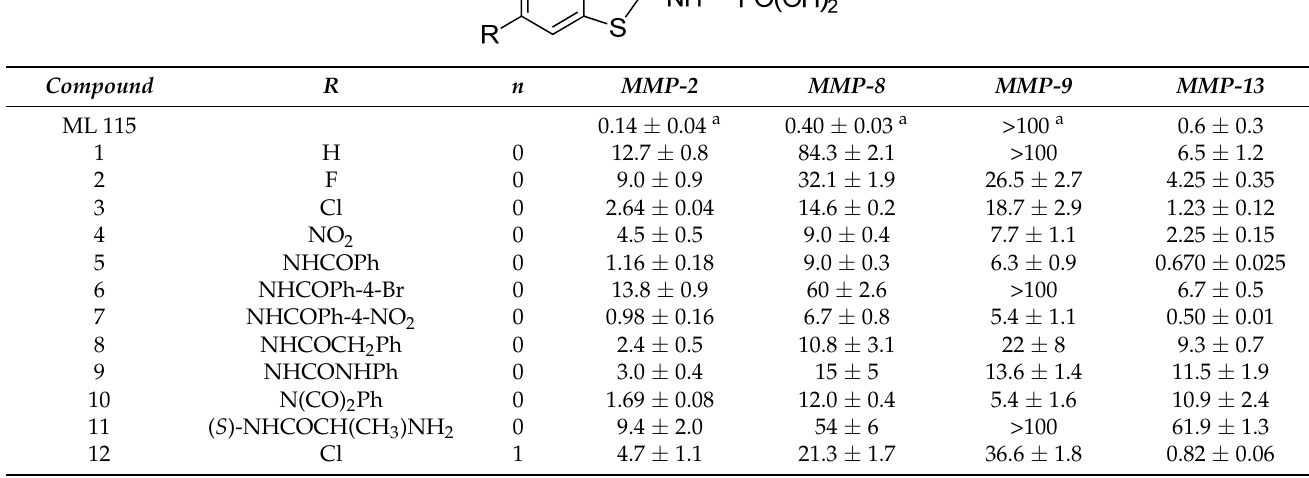
Table 2. In vitro inhibitory activity was evaluated by fluorometric assay using commercially available catalytic domains of MMP-2, -8, -9, and -13. IC 50 µM values are reported as the mean ± SEM (standard error of the mean) of at least 3 independent experiments, which were performed in triplicate.